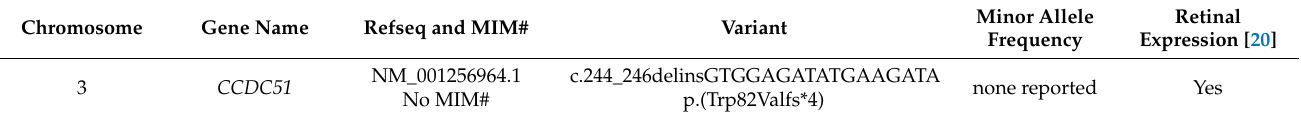
Figure 2 . Schematic drawing of the genomic structure and expression of CCDC51 . ( a ) CCDC51 is located on chromosome 3 and exons 2–4 code for a 411 amino acid protein. Unfilled and filled boxes represent untranslated and translated regions, respectively. The arrow depicts the translation start. M represents the identified mutation. ( b ) The four exons of CCDC51 are expressed in normal human retina (red) [20]. ( c ) CCDC51 RT-PCR encompassing exons 2–4 revealed the presence of the transcript in all tested tissues and cells including human retina, human universal tissues control cDNA, human fibroblasts, human blood, COS-1, and HeLa cells shown on an agarose gel with an expected size of ~660 bp. Table 1. Variants found to be homozygous in the affected girl CIC00843 co-segregates with the